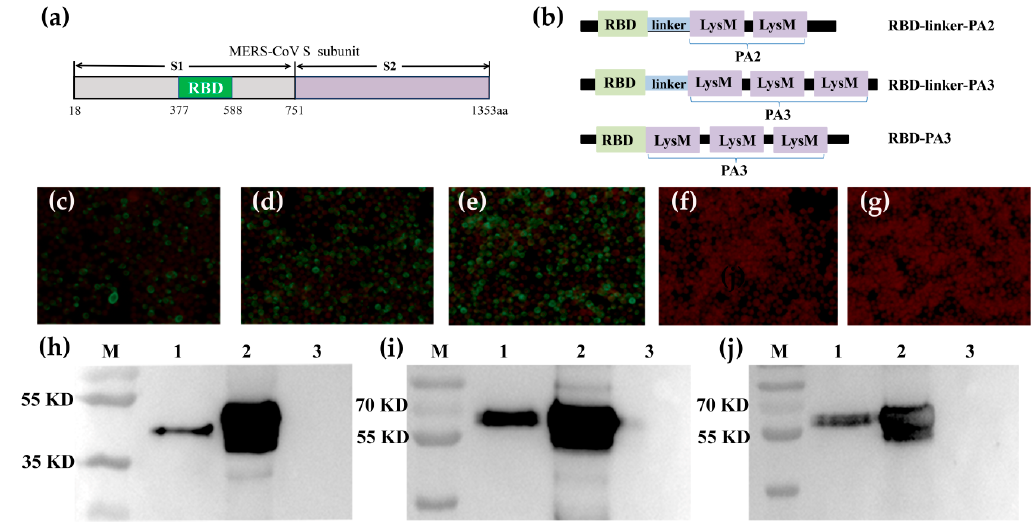
Figure 1. Construction and detection of the fusion proteins expression in baculovirus-infected Sf9 insect cells. ( a ) Schematic illustration of the MERS-CoV-S subunit; ( b ) Schematic illustration of RBD-linker-PA2, RBD-linker-PA3, and RBD-PA3 fusion proteins; ( c – g ) IFA detection of the RLP 2 , RLP 3 , and RP 3 expression in baculovirus-infected Sf9 insect cells (Magnification of microscopy images, × 200). Cells were infected with rBV-RLP 2 , rBV-RLP 3 , rBV-RP 3 in ( c – e ); cells infected with rBV ( f ) and uninfected cells ( g ) were the mock cells. After 48 h, cells were detected with a rabbit anti-MERS-S polyclonal antibody. ( h – j ): Western blot analysis of the rBV-RLP 2 ( h ), rBV-RLP 3 ( i ), rBV-RP 3 ( j ) protein expression in Sf9-infected cells. Expression was detected with a rabbit anti-MERS-S polyclonal